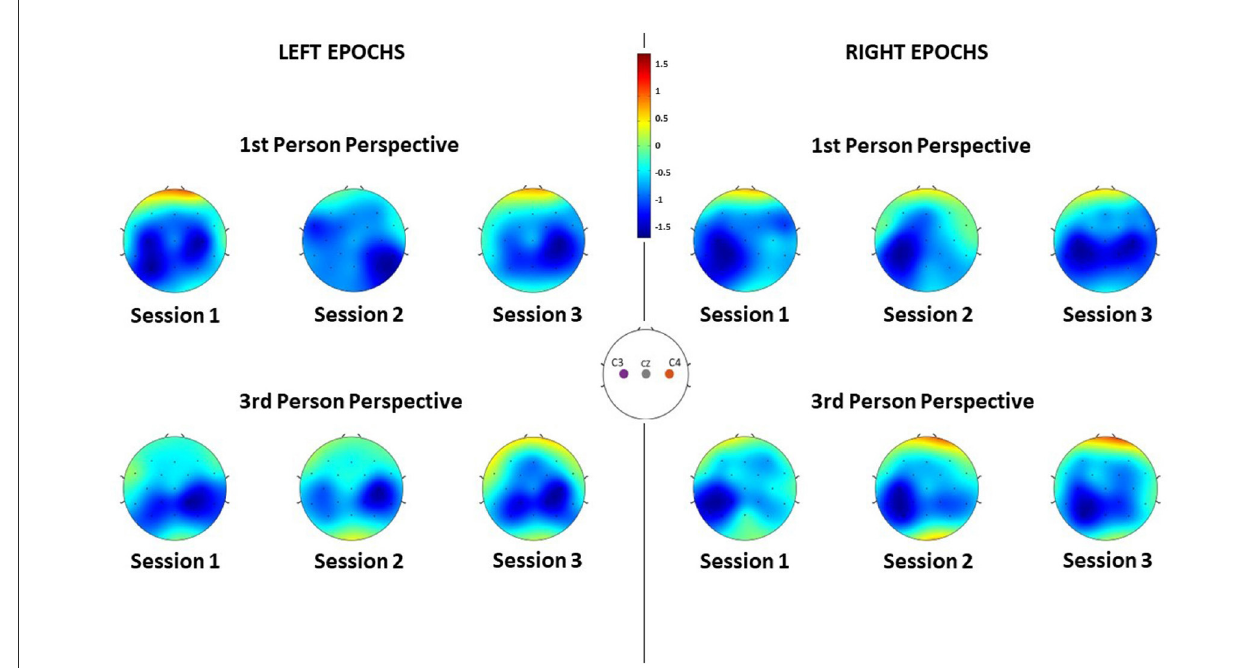
FIGURE5 ERD of each channel averaged along subjects during the different sessions, for each feedback condition and for both left and right MI epochs. Negative values indicate desynchronization of that region.